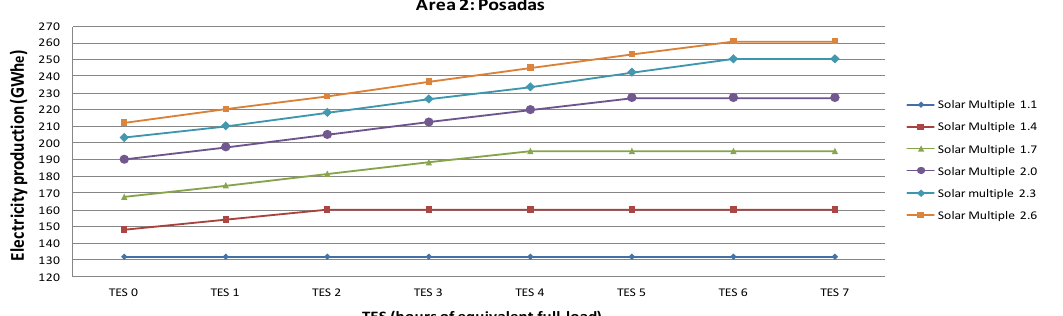
Figure 6. Optimal energy production with SM and TES for Area 1 (Vittoria).